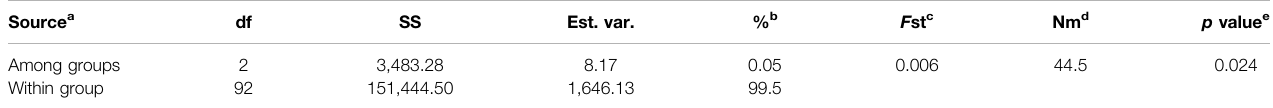
TABLE 1 | Analysis of molecular variance (AMOVA) of the genetic differentiation among and within three subpopulations of Spinacia derived from 16 S. oleracea and 76 S. turkestanica accessions that had 7,065 single nucleotide polymorphisms (SNPs) in common. Source a df SS Est. var. % b F st c Nm d p value e